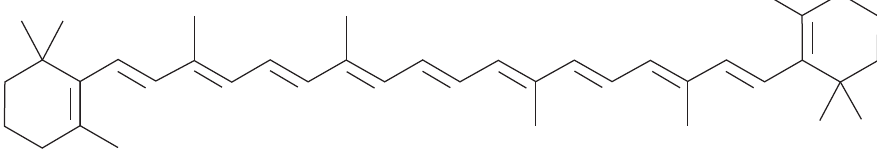
Figure 2: Structure of β